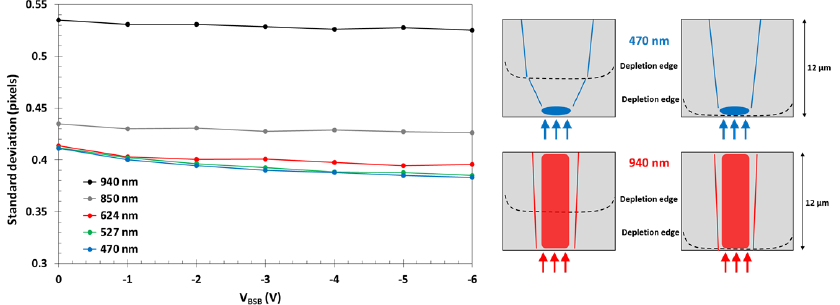
Figure 15. Measurement of the size of a spot illumination in a BSI device with high V pin , medium DDE at five wavelengths, and a diagram illustrating the illustrating the principle of the measurement. The diameter of the pinhole is 10 µm.